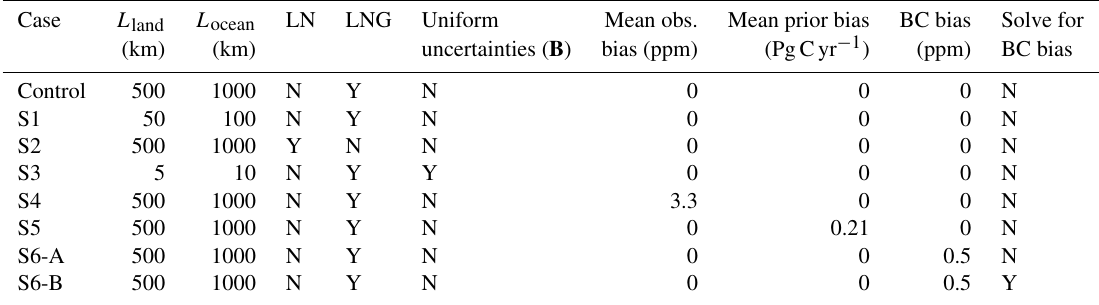
Table 5. A brief description of the sensitivity OSSEs performed for March 2015. Case L land L ocean LN LNG Uniform Mean obs. Mean prior bias BC bias Solve for (km) (km) uncertainties ( B ) bias (ppm) (PgCyr − 1 ) (ppm) BC bias